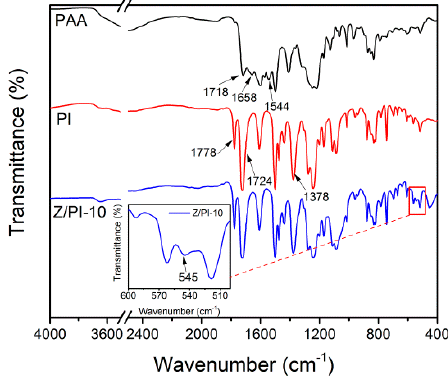
Figure 1. FT-IR spectra of PAA, PI, and Z / PI-10 separators.